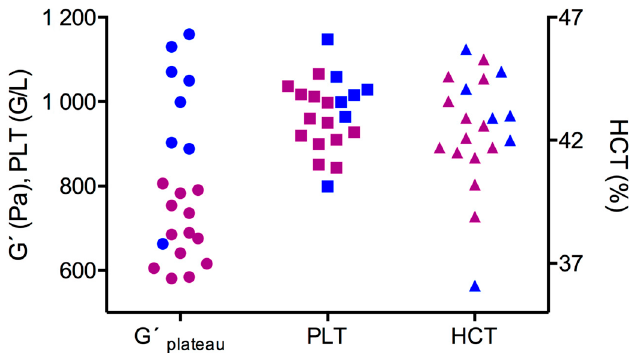
Figure 4. Thrombelastometry of clots from HL and Dahl/SS rats.